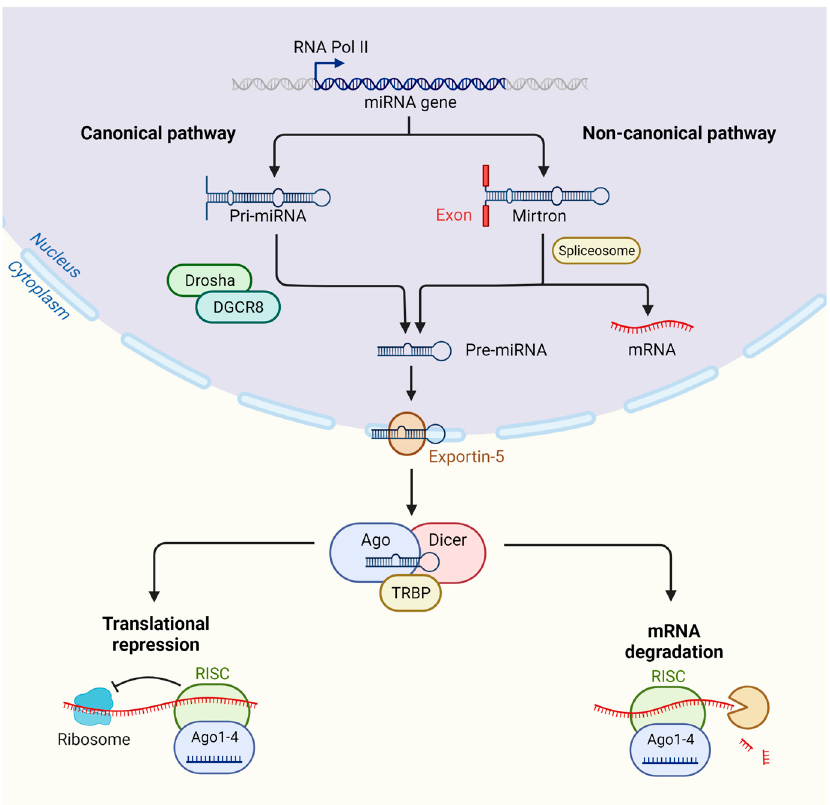
Figure 1. Overview of the biogenesis of miRNAs in animals. After RNA Pol II has transcribed the miRNA gene, an miRNA may undergo further processing through the canonical or non-canonical mechanism of biogenesis. In the canonical pathway, a pri-miRNA will be processed through the microprocessor complex, composed of Drosha and DGCR8 to form a pre-miRNA. The non-canonical pathway, on the other hand, is regarded as Drosha/DGCR8-independent with a pre-miRNA formed through splicing from the entre intron. After this stage, the pre-miRNA may enter to join the canonical pathway. Upon being translocated to the cytoplasm through exportin-5, along with GTP-binding nuclear cofactor Ran-GTP, pre-miRNA is then processed by the RNase III enzyme Dicer, leading to the production of a smaller double-stranded miRNA molecule. Through the interaction between the Dicer and TAR RNA-binding protein (TRBP), further cleavage will occur, resulting in an miRNA duplex structure. The final processed double-stranded miRNA is bound by the Argonaute protein (AGO), leading to the generation of the RNA-induced silencing complex (RISC). The AGO-bound miRNA duplex will then unwind, with either the separated 5p or 3p strand selected and incorporated into the mature RISC complex. (Created with